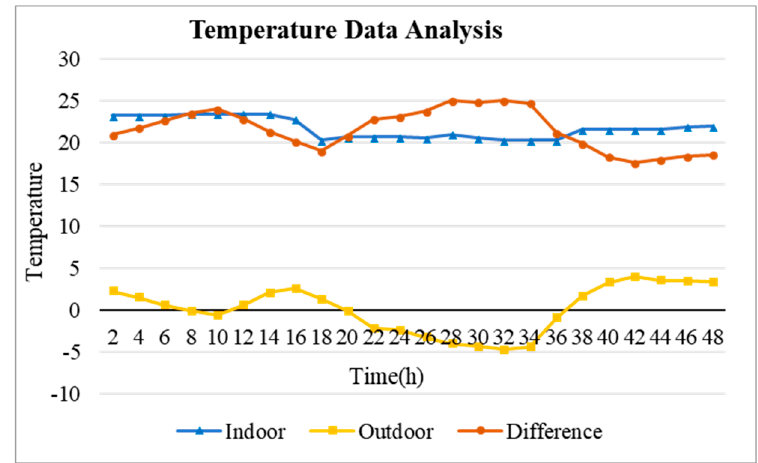
Figure 5. Temperature Data Analysis.